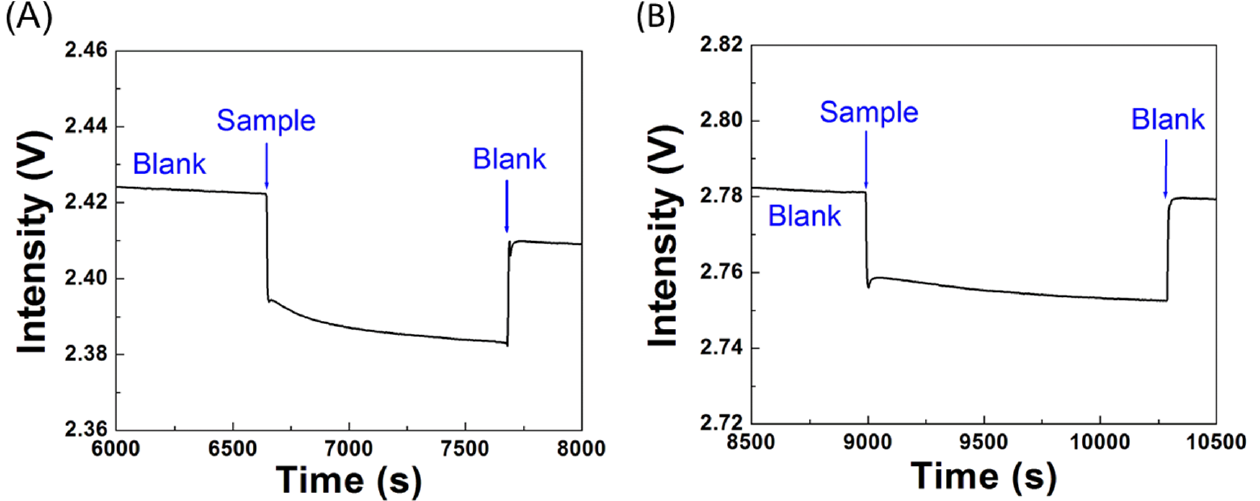
Figure 9. Real-time sensorgrams of a NP-A48-functionalized sensor chip in response to ( A ) a negative sample spiked with 5 µ g/mL (0.11 µ M) N-protein and ( B ) an unspiked negative sample .